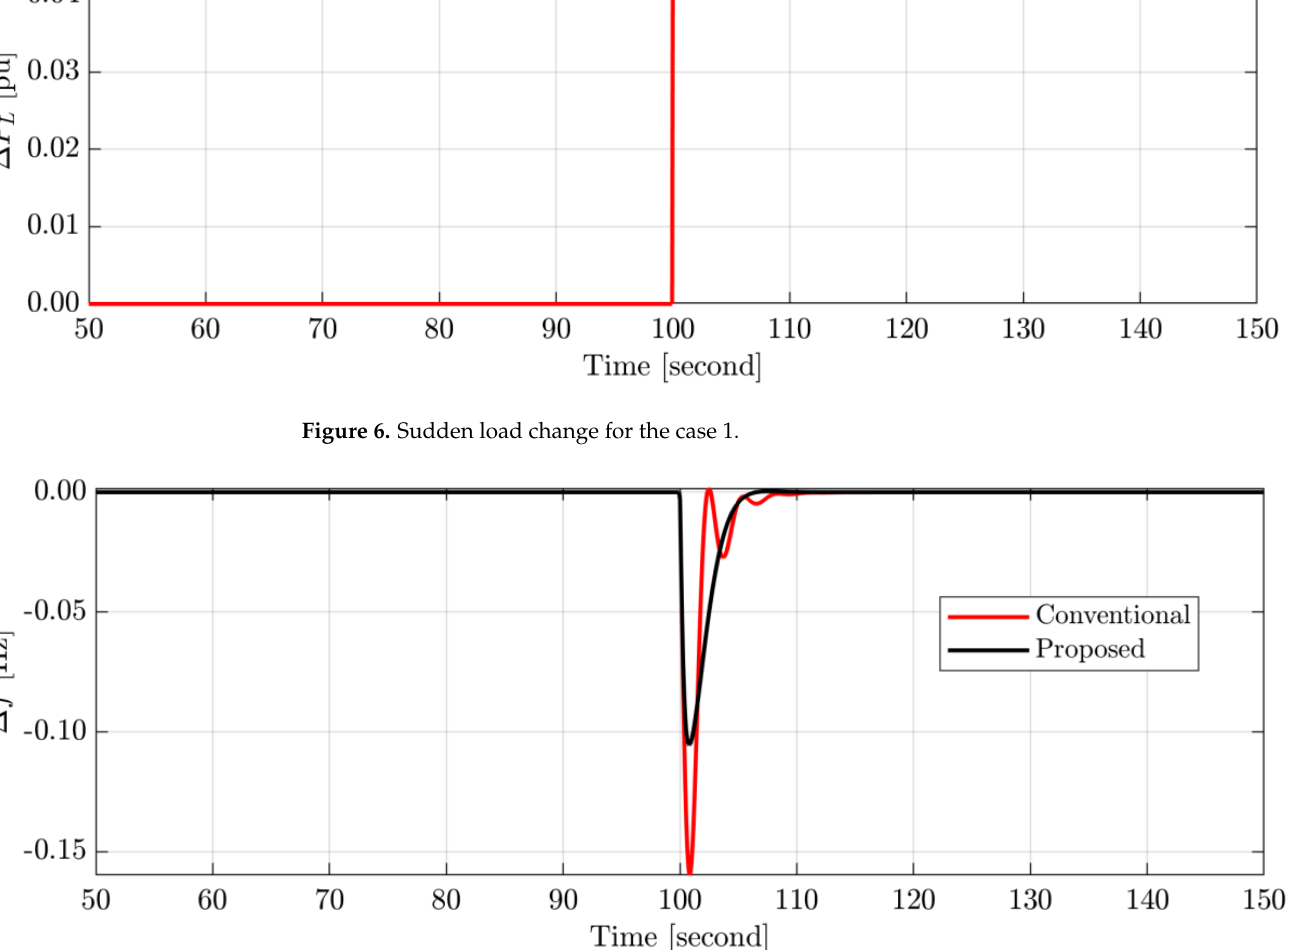
Figure 7. System frequency deviation of the studied µG for the case 1.